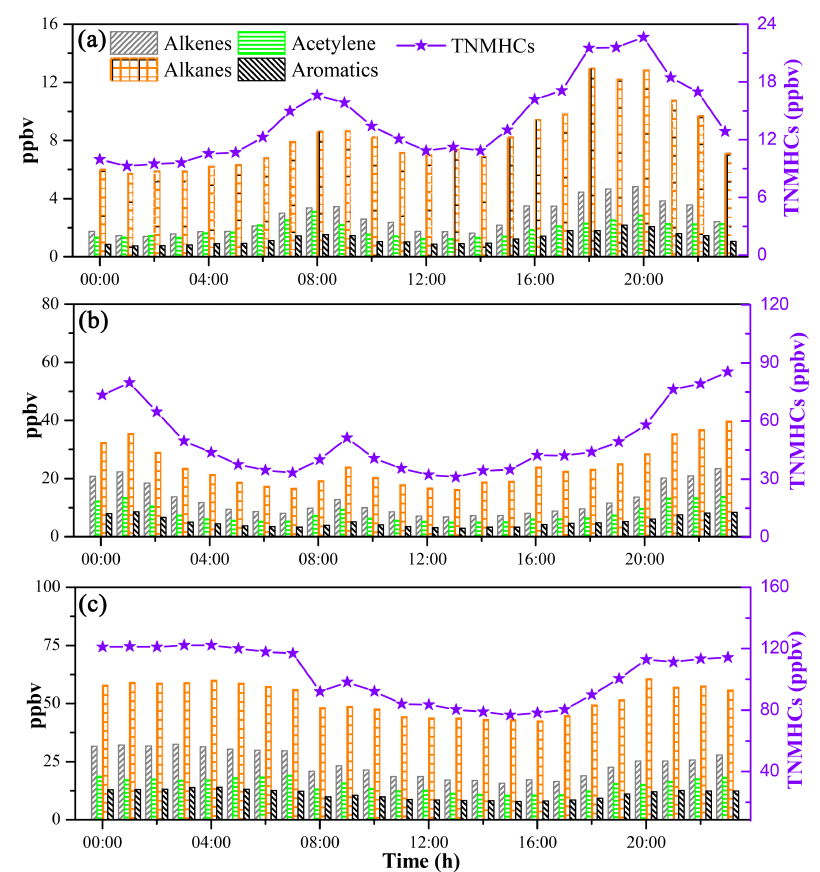
Figure 2. Diurnal variations in alkanes, acetylene, alkenes, aromatics, and TNMHC during (a) clear days, (b) light haze days, and (c) heavy haze days.